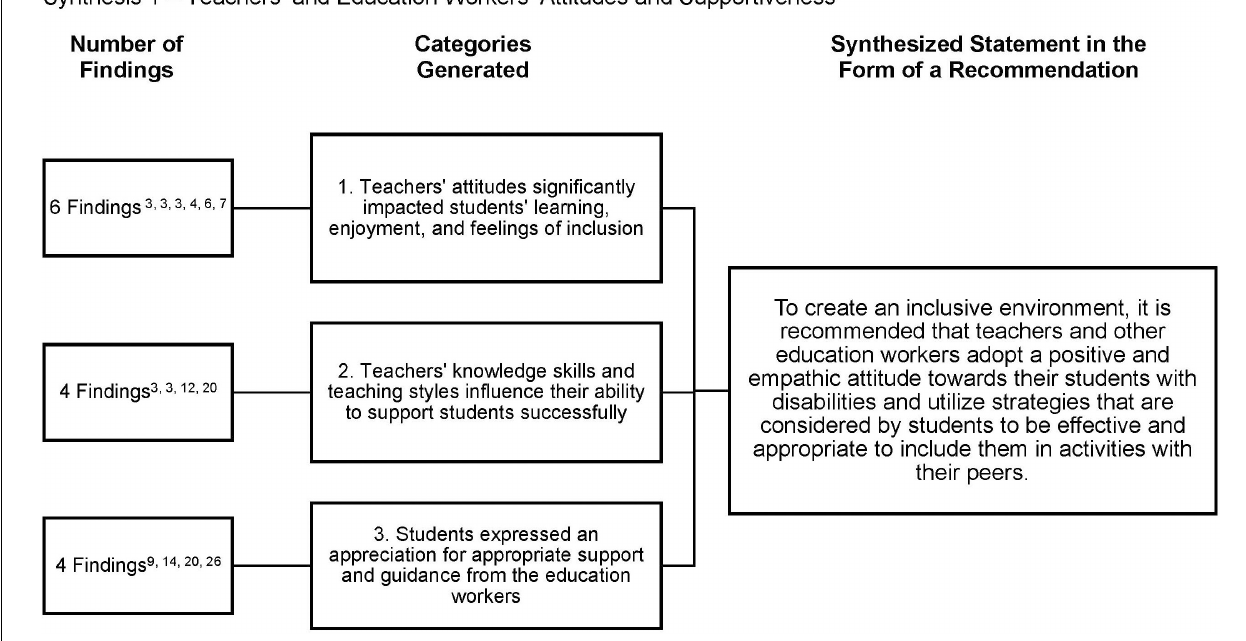
excluded from school activities ( category 5, supported by